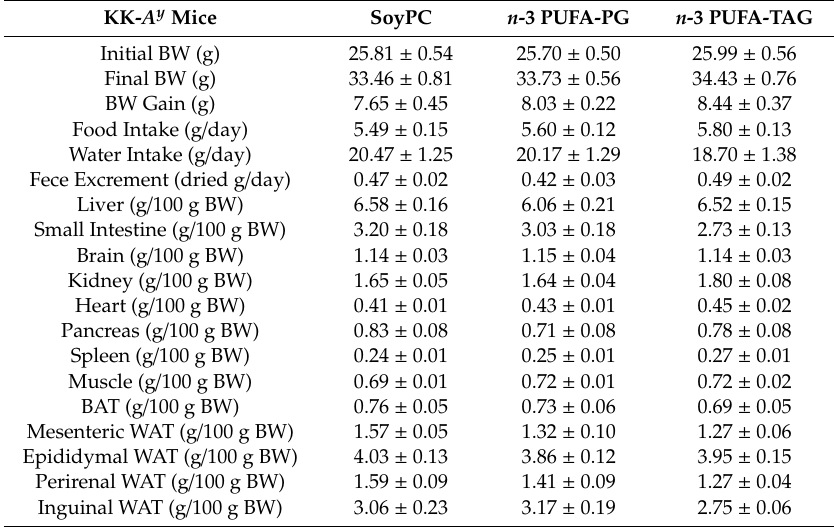
Table 2. Body and tissue weights, food and water intake of KK- A y